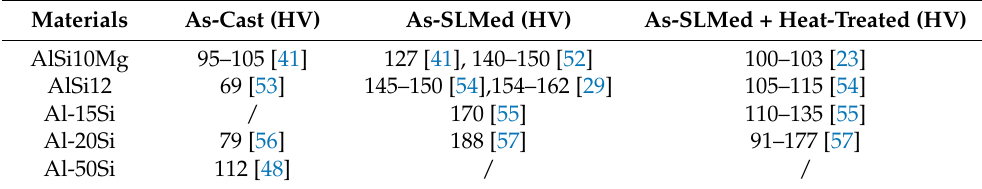
Table 4. Microhardness of the Al-Si alloys manufactured by cast, SLM, and SLM with heat treatment.